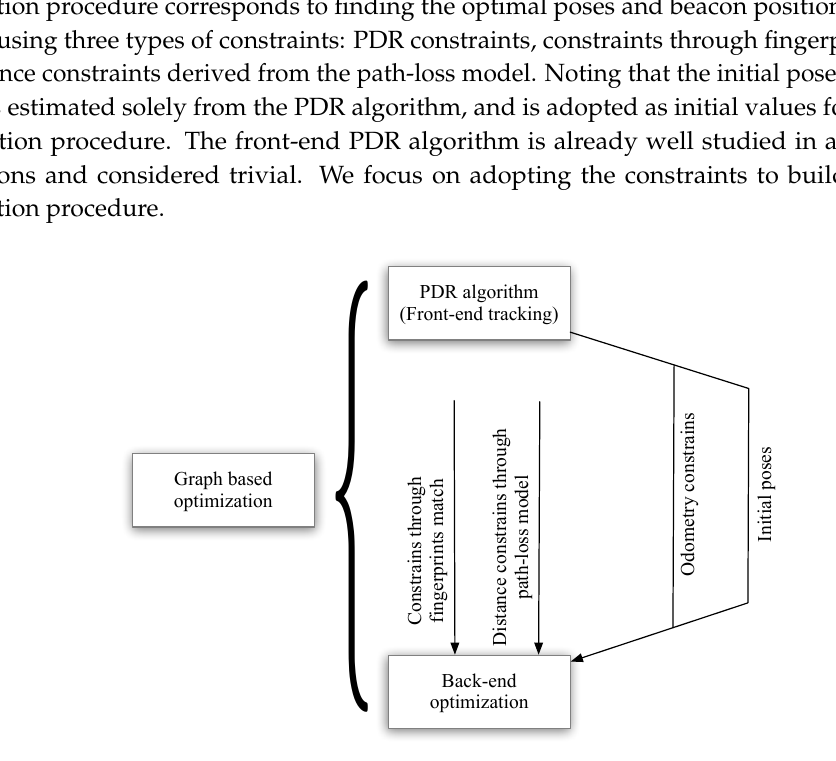
Figure 2. The graph SLAM procedures and its implementation in our